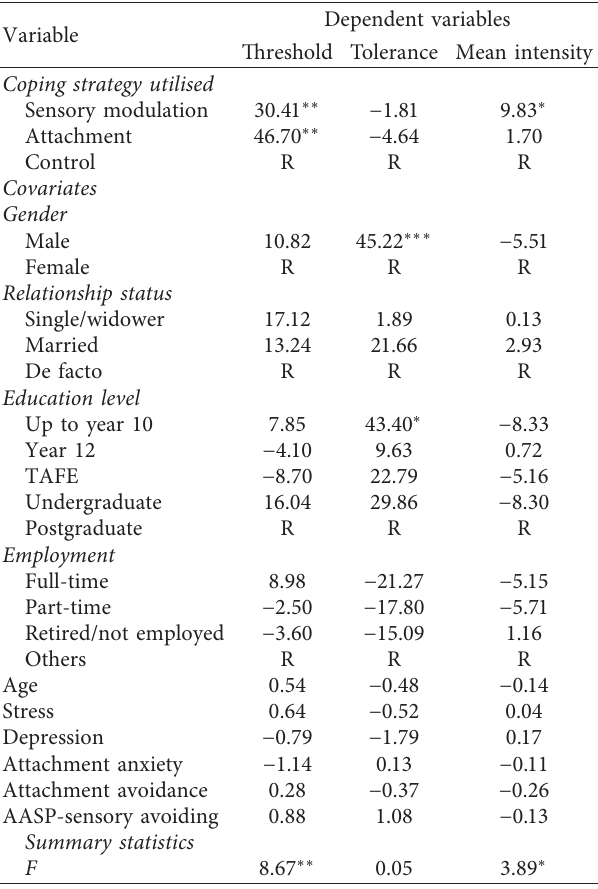
Table 3: B values and summary statistics for final three ANCOVA models for pain threshold, tolerance, and mean intensity, N � 272. Dependent Variable